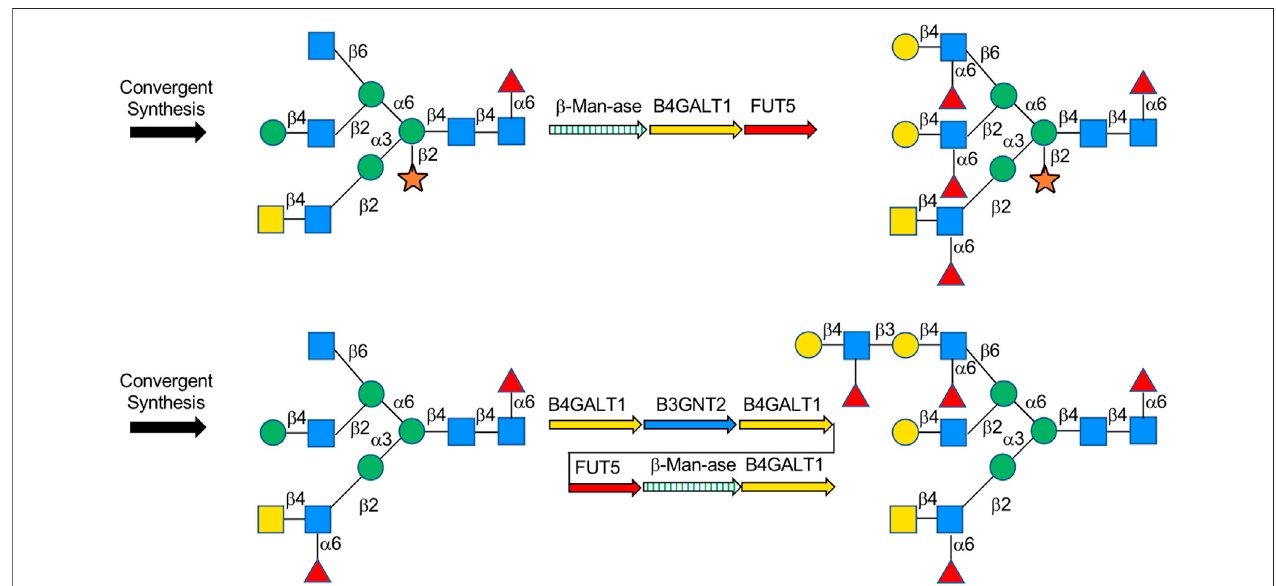
FIGURE 9 | Chemoenzymatic synthesis of complex-type N